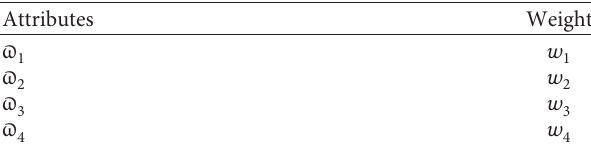
Table 10: The weights of attributes.